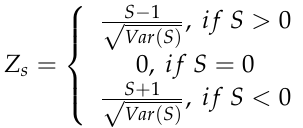
( b ) Annual cycle of PET (mm) over Myanmar from averaged from 1986 to 2015. Figure S2 Same as Figure 9, but for correlation between IOD and SPEI. Figure S3 Same as Figure 11, but for Wheat crop